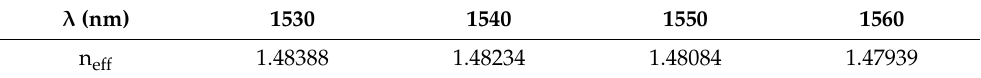
Figure 3. Normalized power as a function of strip height (SiN).